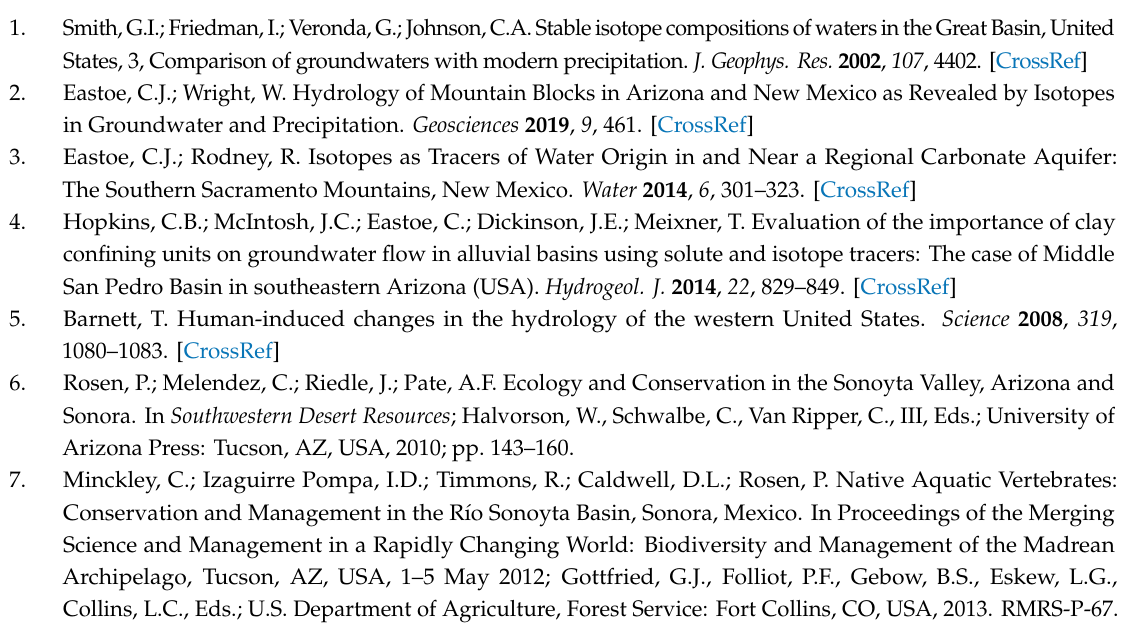
Table S1: Sampling sites